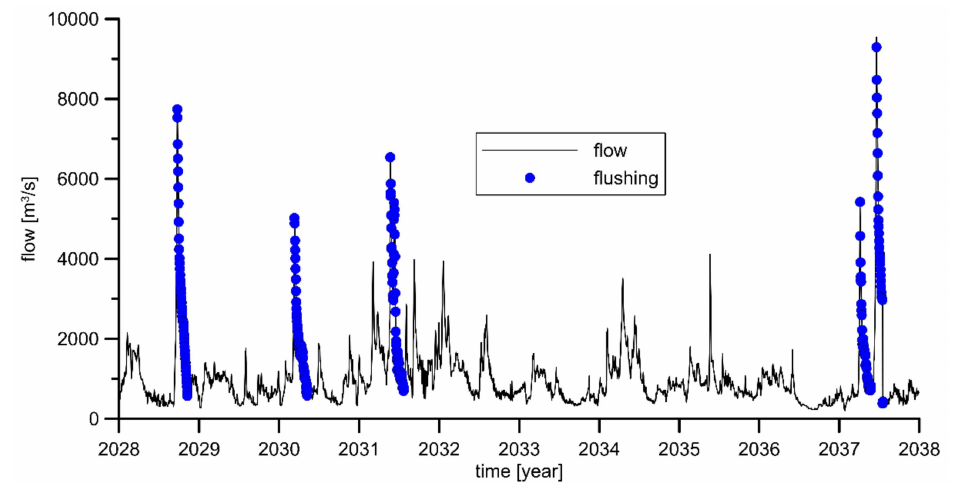
Figure 7. Exemplary flooding periods selected for the flushing process.